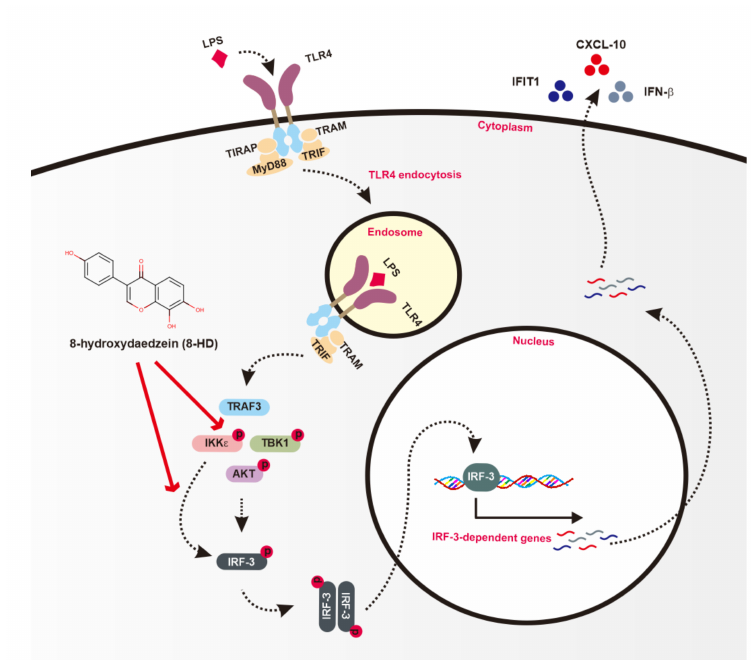
Figure 6. Putative inhibitory e ff ect of 8-HD in the IRF-3 signaling pathway. 8-HD inhibits IRF-3 activation and subsequently IRF-3-dependent gene transcription by direct suppression of kinase activity of IKK ε and by interfering with complex formation composed of TRAF3, TANK, and IKK ε .